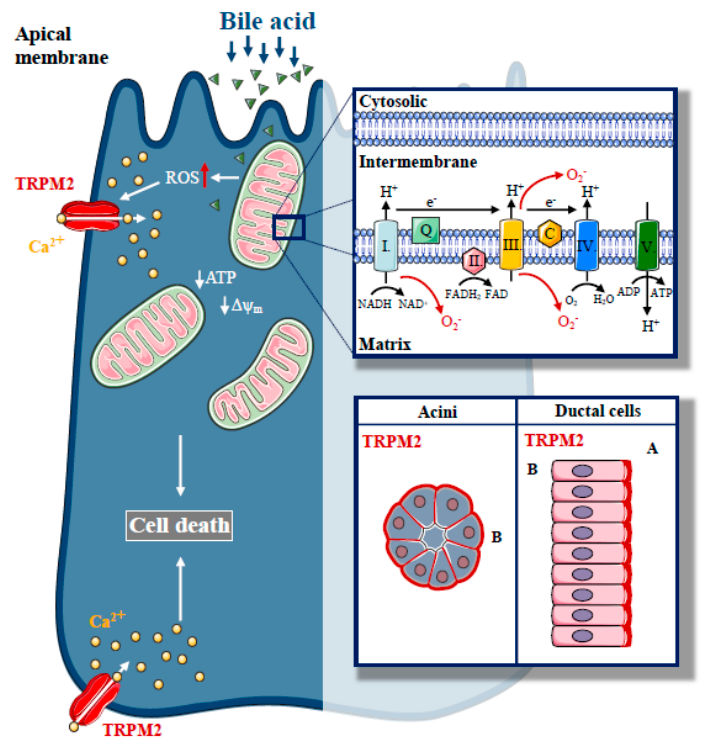
Figure 3. The role of Transient Potential Melastatin-like 2 (TRPM2) in biliary pancreatitis. Increased, unbalanced production of ROS, which are generated during physiological mitochondrial respiration, are mainly derived from complexes I and III of the mitochondrial electron transport chain, a crucial event in the pathogenesis of biliary acute pancreatitis. In our recent study, we described the expression of a redox sensitive cation channel, TRPM2, in the exocrine pancreas with basolateral localisation in acinar cells and apical localisation in ductal cells. H 2 O 2 -induced oxidative stress activated TRPM2, whereas TRPM2 knockout decreased the bile acid-induced Ca 2 + elevation in acinar cells and prevented acinar cells from bile-acid-induced necrosis. Genetic deletion of TRPM2 reduced the severity of bile-acid-induced experimental pancreatitis.